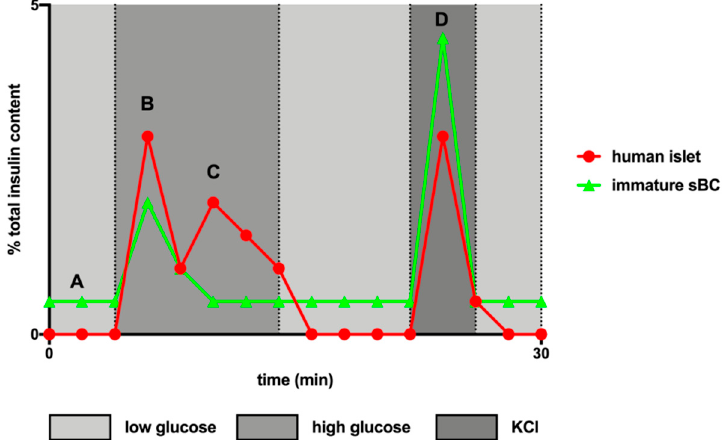
Figure 3. Dynamic glucose stimulated insulin secretion profiles depend on the maturation state of beta cells. Schematic representation of idealized dynamic glucose stimulated insulin secretion (dGSIS) profiles for cadaveric human islets 24 h post retrieval and immature sBCs obtained by perifusion. The values are presented as a percentage of total insulin content of the cluster of cells recovered following perifusion. Low glucose is 0.5 mM glucose in Krebs-Ringer Bicarbonate (KRB) buffer, high glucose is 16.7 mM glucose in KRB buffer and KCl is 30 mM KCl + 16.7 mM glucose in KRB buffer. A, Immature sBCs present with an increased glucose secretion in basal glucose. B, Immature sBCs respond to high glucose though often not to the same degree as human islets. C, Immature sBCs lack the characteristic second phase response to high glucose observed in human islets. D, Immature sBCs often show an exaggerated or so-called “uncontrolled” response to membrane depolarization with KCl; while human islets respond by secreting insulin at a level similar to their maximum response to high glucose.